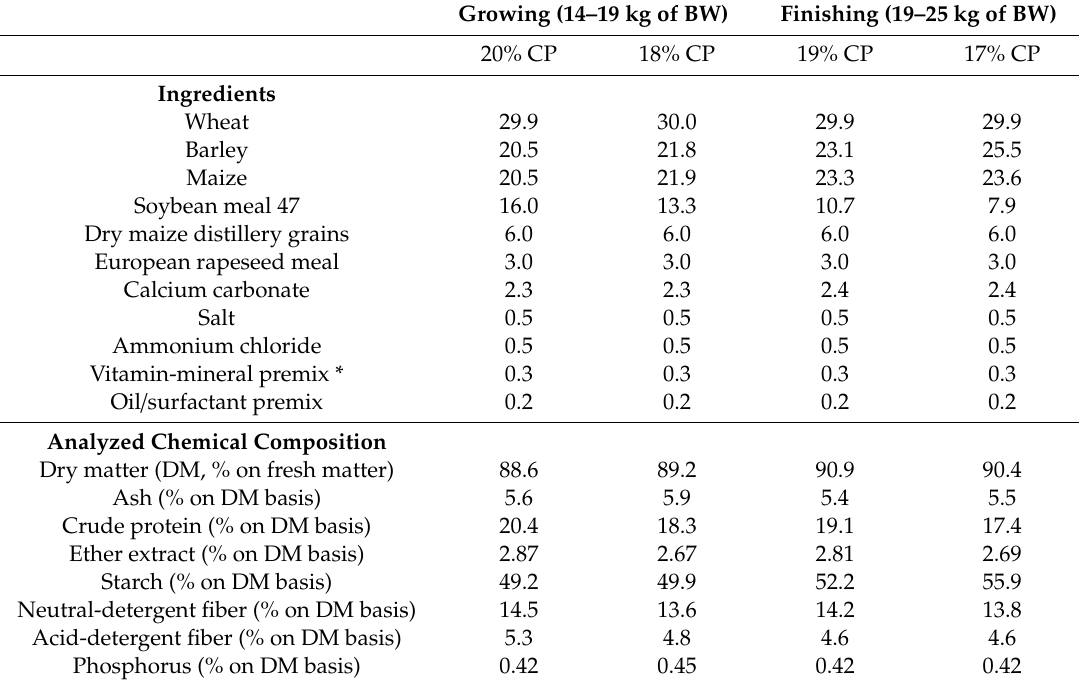
* Ingredients of vitamin-mineral premix contained in each kilogram of feed: Vitamin A, 9900 UI; Vitamin D 3 , 2250 UI; Vitamin E, 300 UI; Vitamin B1, 1 mg; Zn, 77.7 mg; Mn, 35.6 mg; Cu, 2.2 mg; Co, 0.96 mg; I, 0.62 mg; Se, 0.20 mg; BHT (E321), 62.5 mg and Propyl gallate (E310), 7.5